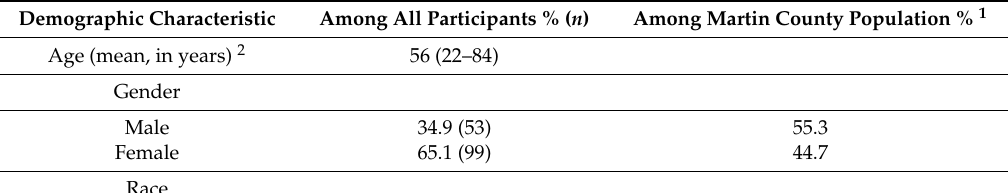
Table 1. Demographic characteristics of participants (N =